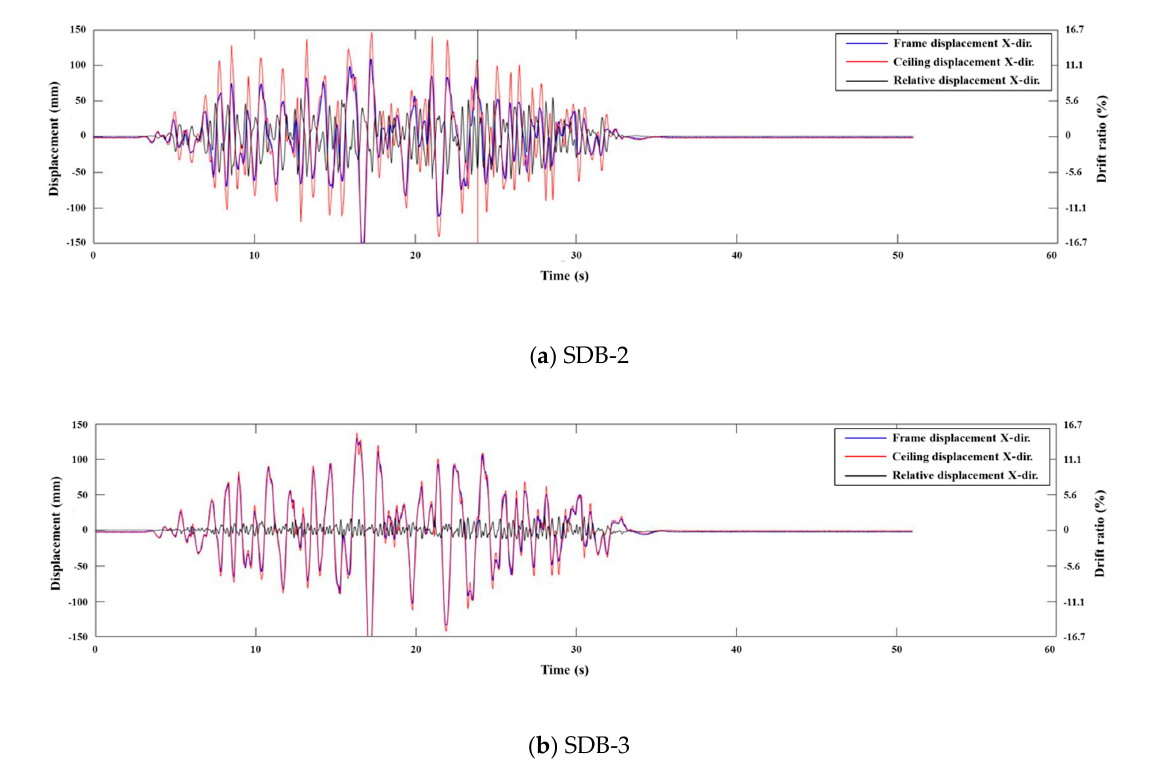
Figure 14. Relative displacement between the test frame and the ceiling systems: ( a ) SDB-2, Test 8 (2.16 g); ( b ) SDB-3, Test 8 (2.16 g).